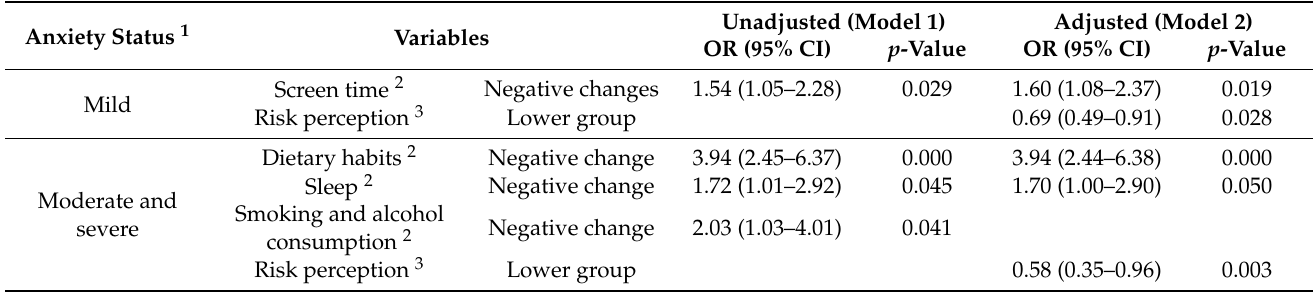
Table 3. Associations between lifestyle changes, risk perception, and anxiety.